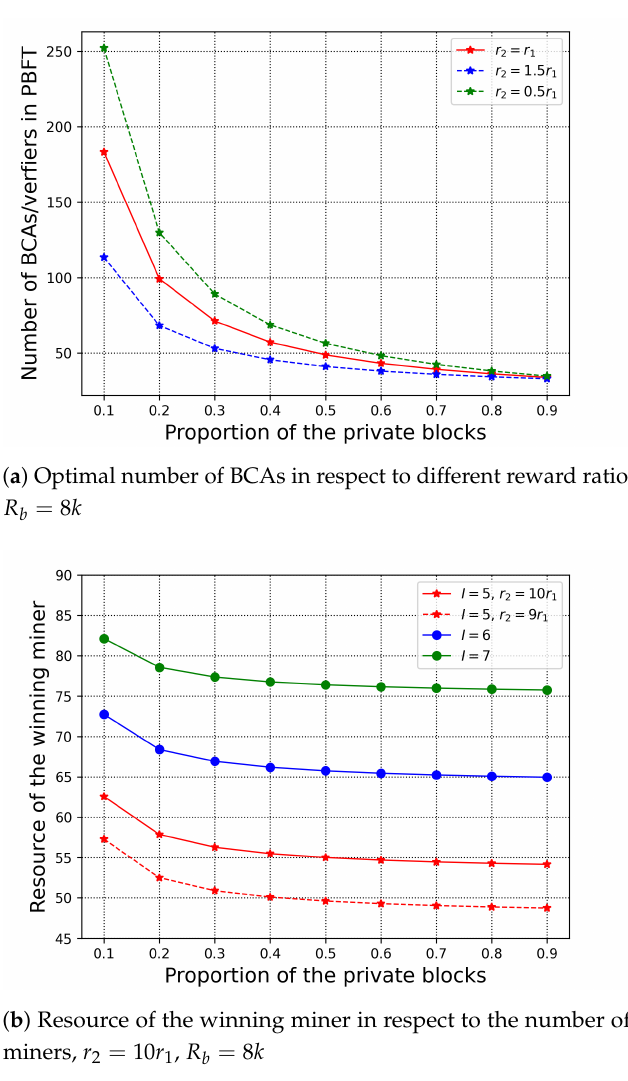
Figure 6. Proportion of the private blocks in respect to the number of BCAs and the resource of winning